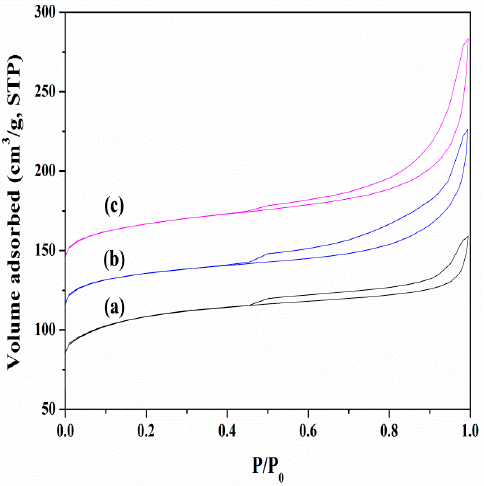
Figure 2. Adsorption/desorption isotherms of nitrogen at 77 K on the alkaline-treated ZSM-5 and the parent ZSM-5 zeolites: ( a ) H-Z-0; ( b ) H-Z-20; and ( c ) H-Z-30. For clarity the isotherms of H-Z-20 and H-Z-30 have been shifted upward by 50 cm 3 /g and 100 cm 3 /g, respectively. Table 1. The amount of Al atoms, pore structure parameters and the acid sites of the parent and mesoporous ZSM-5 zeolites.